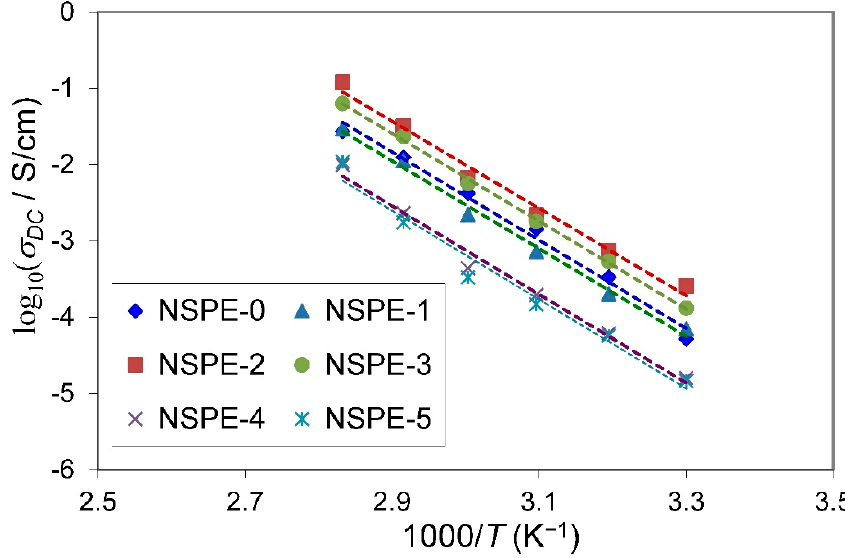
Figure 7. Temperature-dependent direct current (DC) conductivity for PVA/NH 4 NO 3 /ZnO NSPEs.